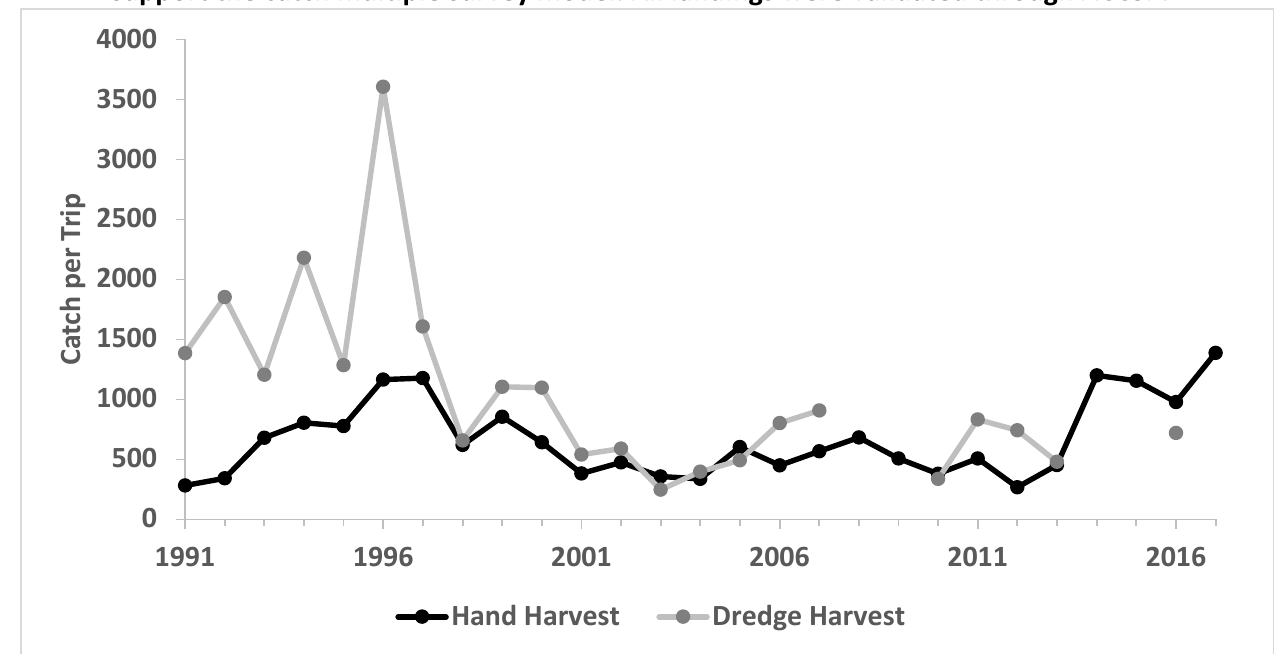
Figure 6. Delaware’s commercial horseshoe crab catch rates (mean number of crabs per trip). Missing values for dredge harvest in 2008, 2009, 2014, 2015, and 2017 are due to no dredge fishery in those years. Source: Delaware’s Department of Fish and Wildlife’s 2017 Compliance